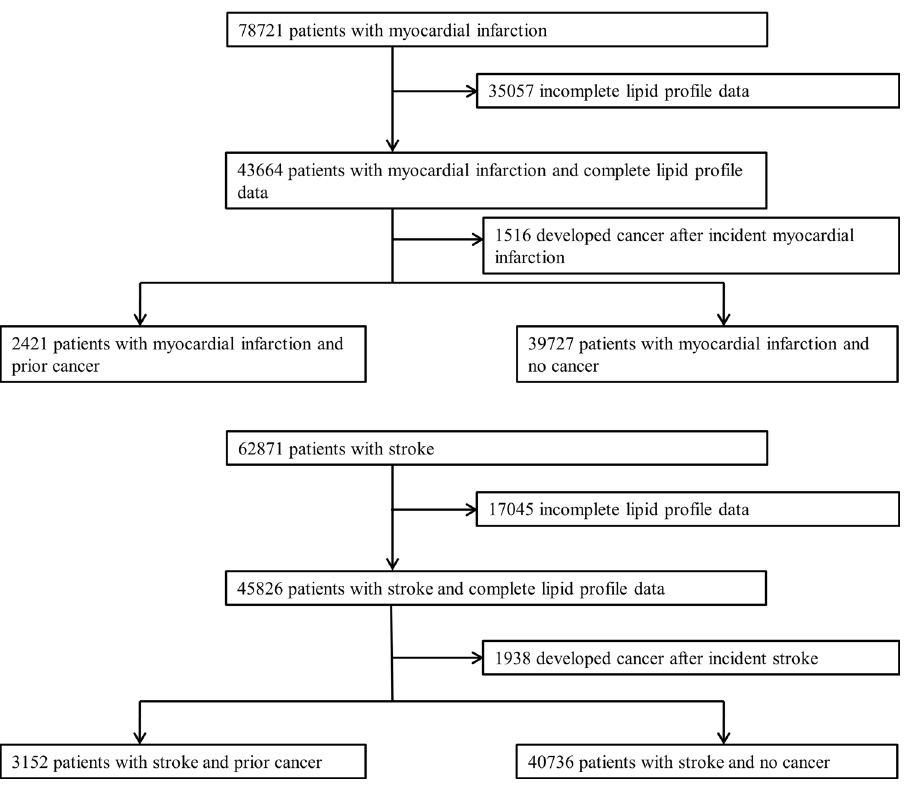
Figure 1. Flow chart of study patients. Study cohort profile for primary